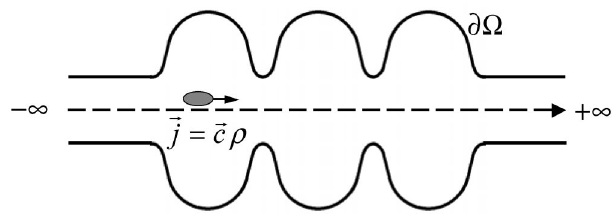
FIG. 1. Charged particle bunch moving through an accelerat- ing structure supplied with infinite